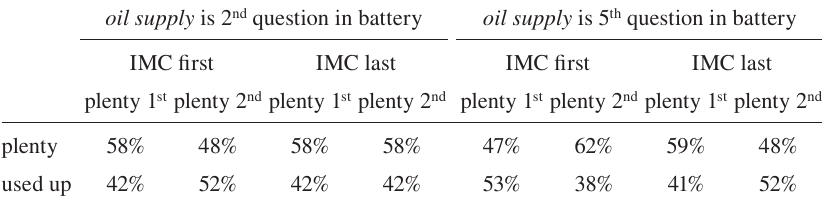
Task order by IMC order by response order on oil supply response